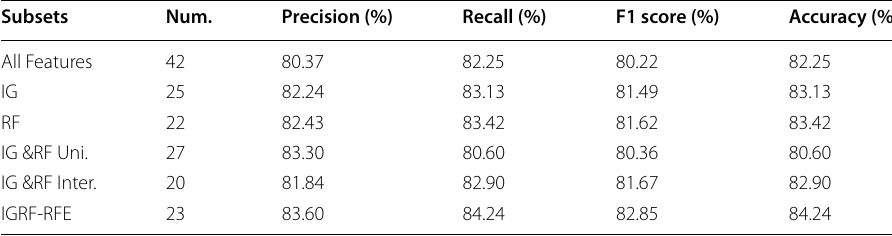
Table 8 Performance of different feature subsets Subsets Num. Precision (%) Recall (%) F1 score (%) Accuracy (%) All